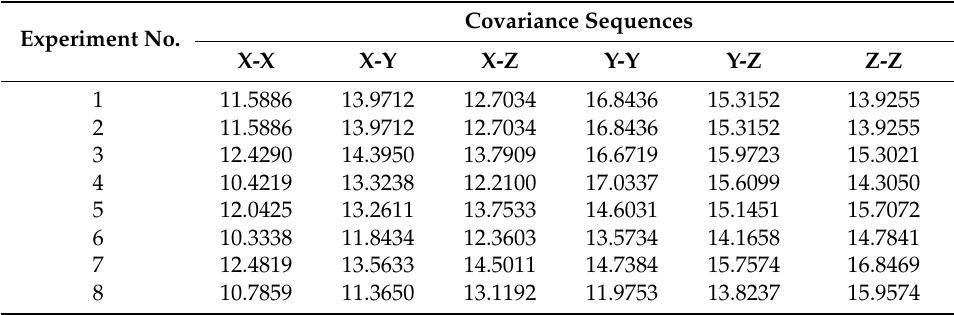
Table 7. Array of covariance sequences derived from Grey relation coefficients.